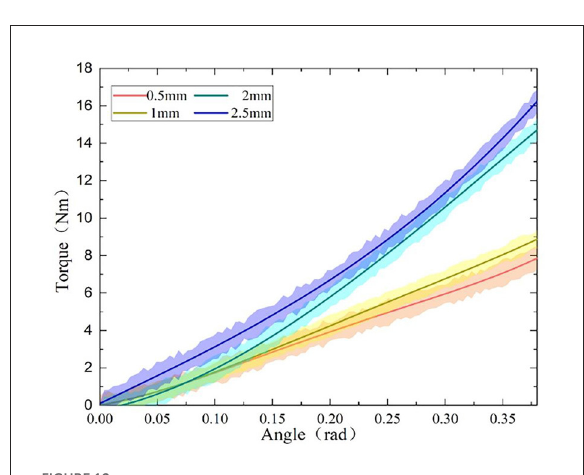
FIGURE12 Torque-deformation angle curve.